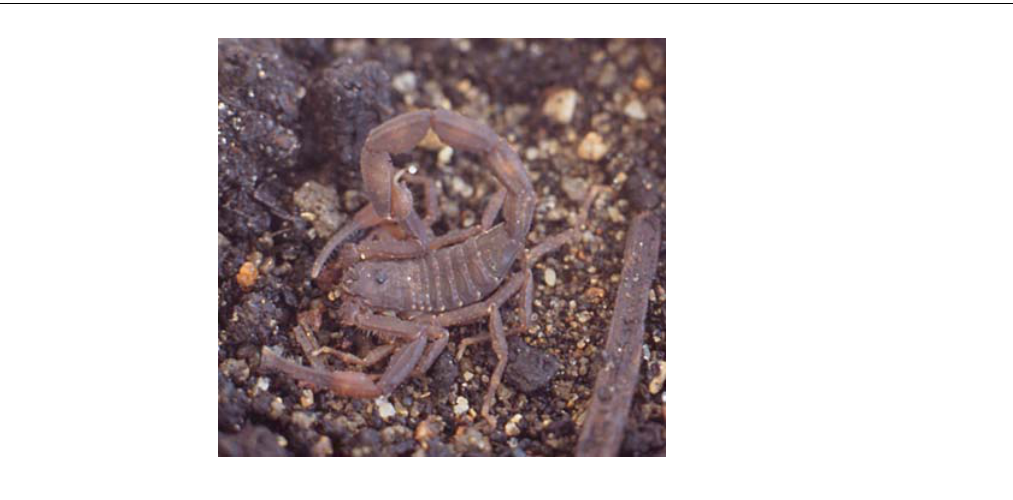
Figure 24. Fifth instar adult male of Tityus metuendus issued from parthenogenetic reproduction.